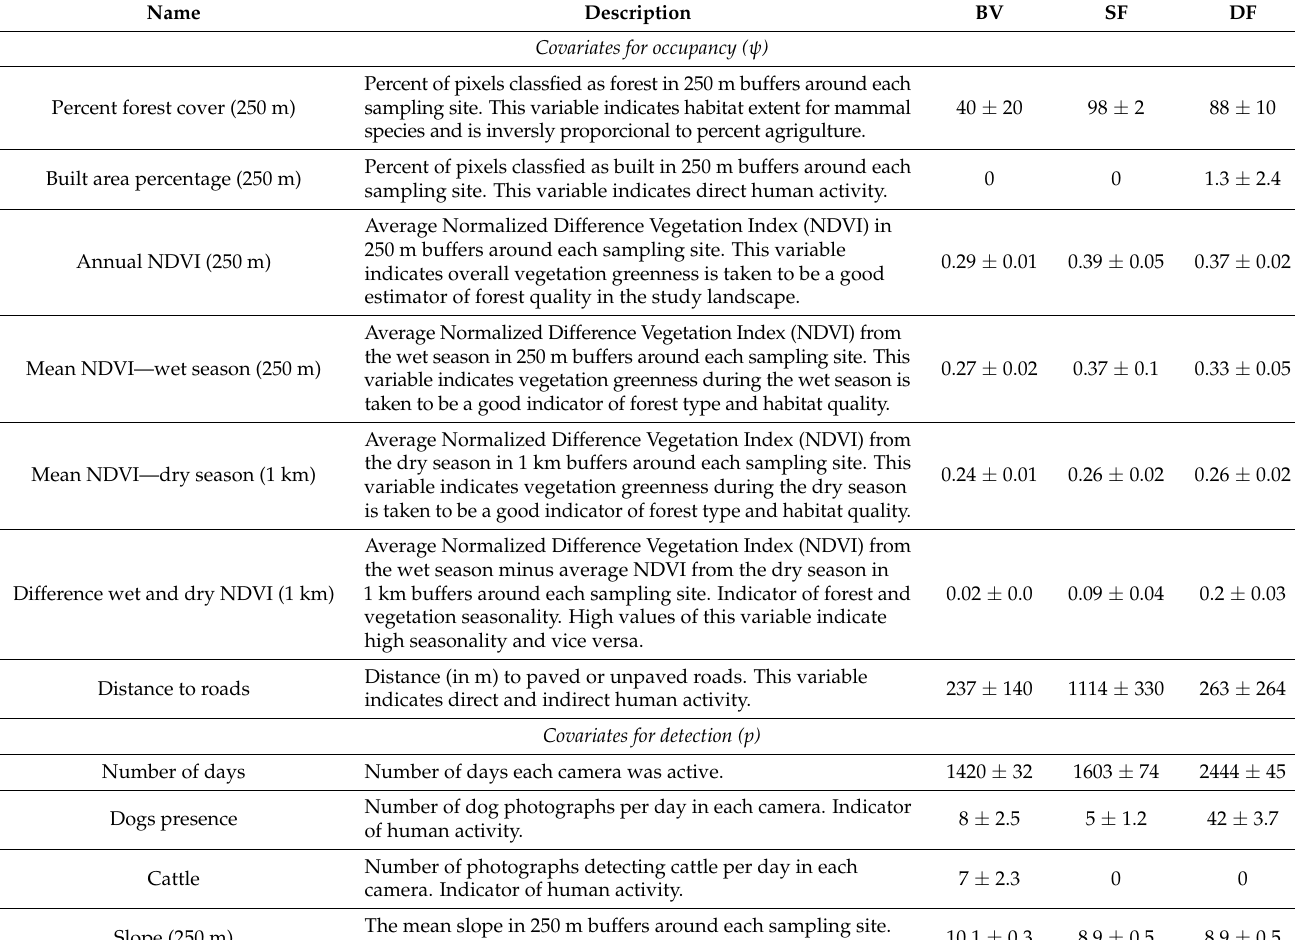
Table 1. Description of predictors used as covariates for occupancy ( ψ ) and for detection (p) in the multi-species occupancy analysis and the mean ( ± standard deviation) of each predictor for each sampling area. Sampling sites: Bosque Verde deciduous forest (BV), Punta Gorda deciduous forest (DF) and Punta Gorda semi-deciduous forest